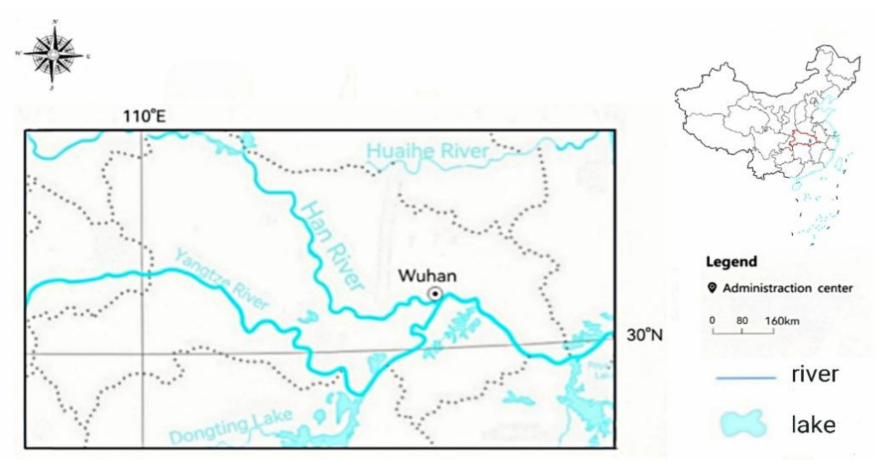
Figure 5. Map of study